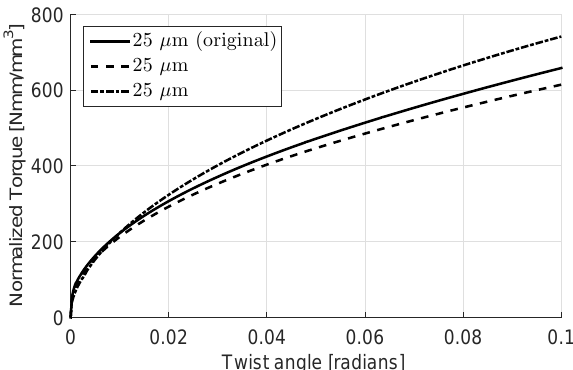
Figure 6. Torque vs. twist angle curves with 25 µ m disc radius and 2 sets of additional randomly generated orientations.